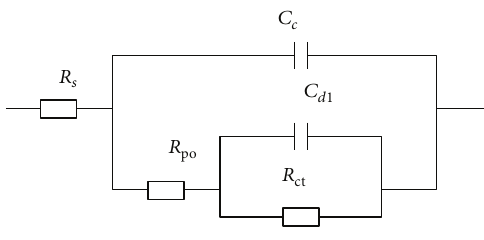
Figure 1: Equivalent electric circuit